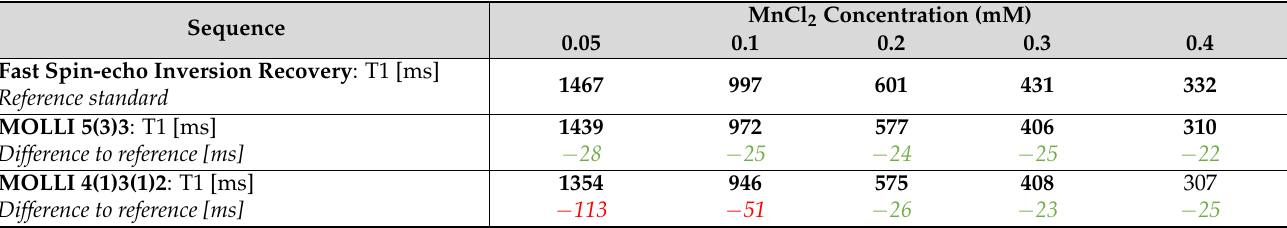
Table 1. In vitro T1 mapping